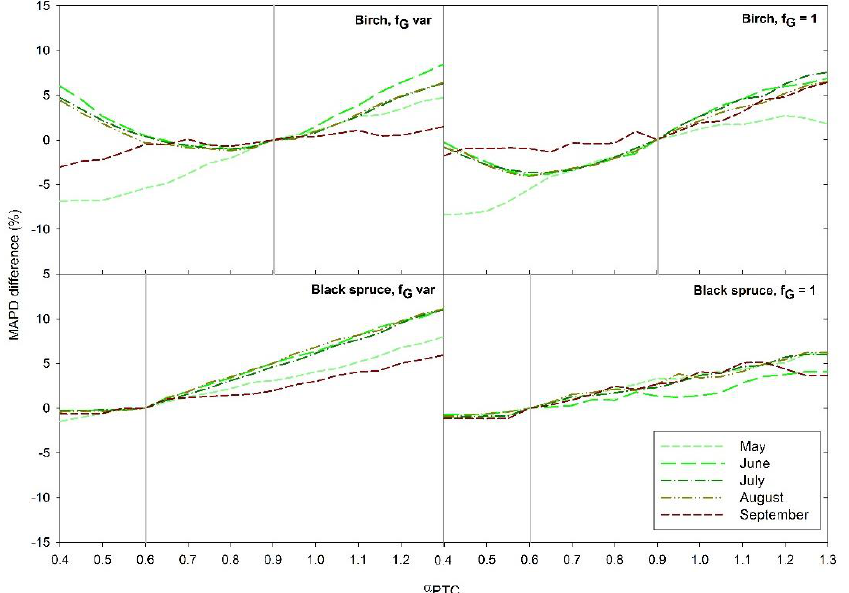
Figure 7. Error percentage (MAPD) differences on LE estimation running TSEB with α PTC value increases at 0.05 intervals from 0.4 to 1.3 for both black spruce and birch, respectively, with (a) a variable f G derived from the EVI and NDVI ratio and (b) a f G = 1. Results were monthly averaged from May to September for the 2012–2016 period. Error percentage differences were obtained by subtracting a MAPD value from LE estimated at each 0.05 interval in the value of α PTC from 0.4 to 1.3 from the reference α PTC value of 0.6 and 0.9 for black spruce and birch, respectively. Vertical grey lines are the reference adjusted α PTC values used in TSEB to model LE for black spruce and birch.